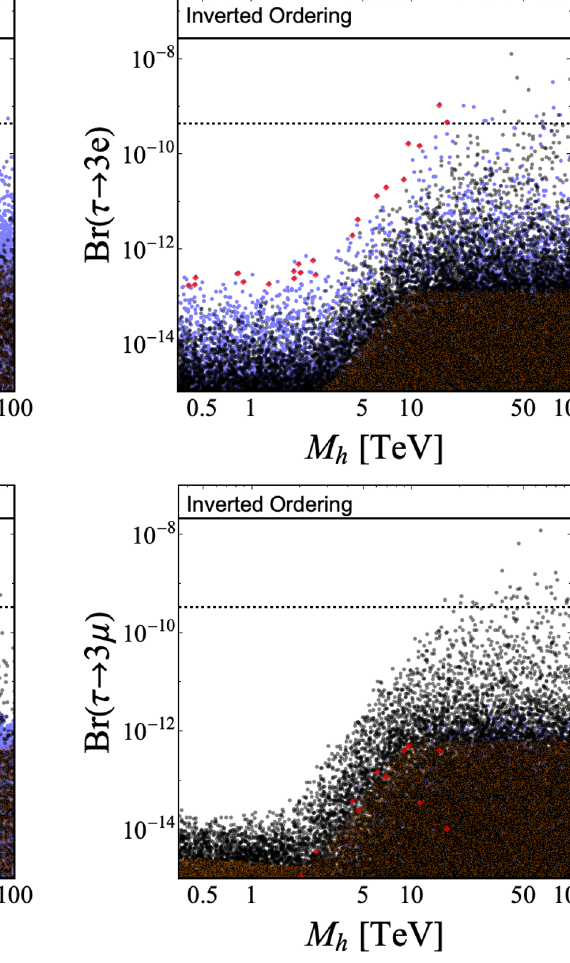
Figure 7 . Branching ratio of tri-lepton tau decays as a function of the mass M h . The colours are the same as in figure 2. Dashed lines indicate prospected experimental